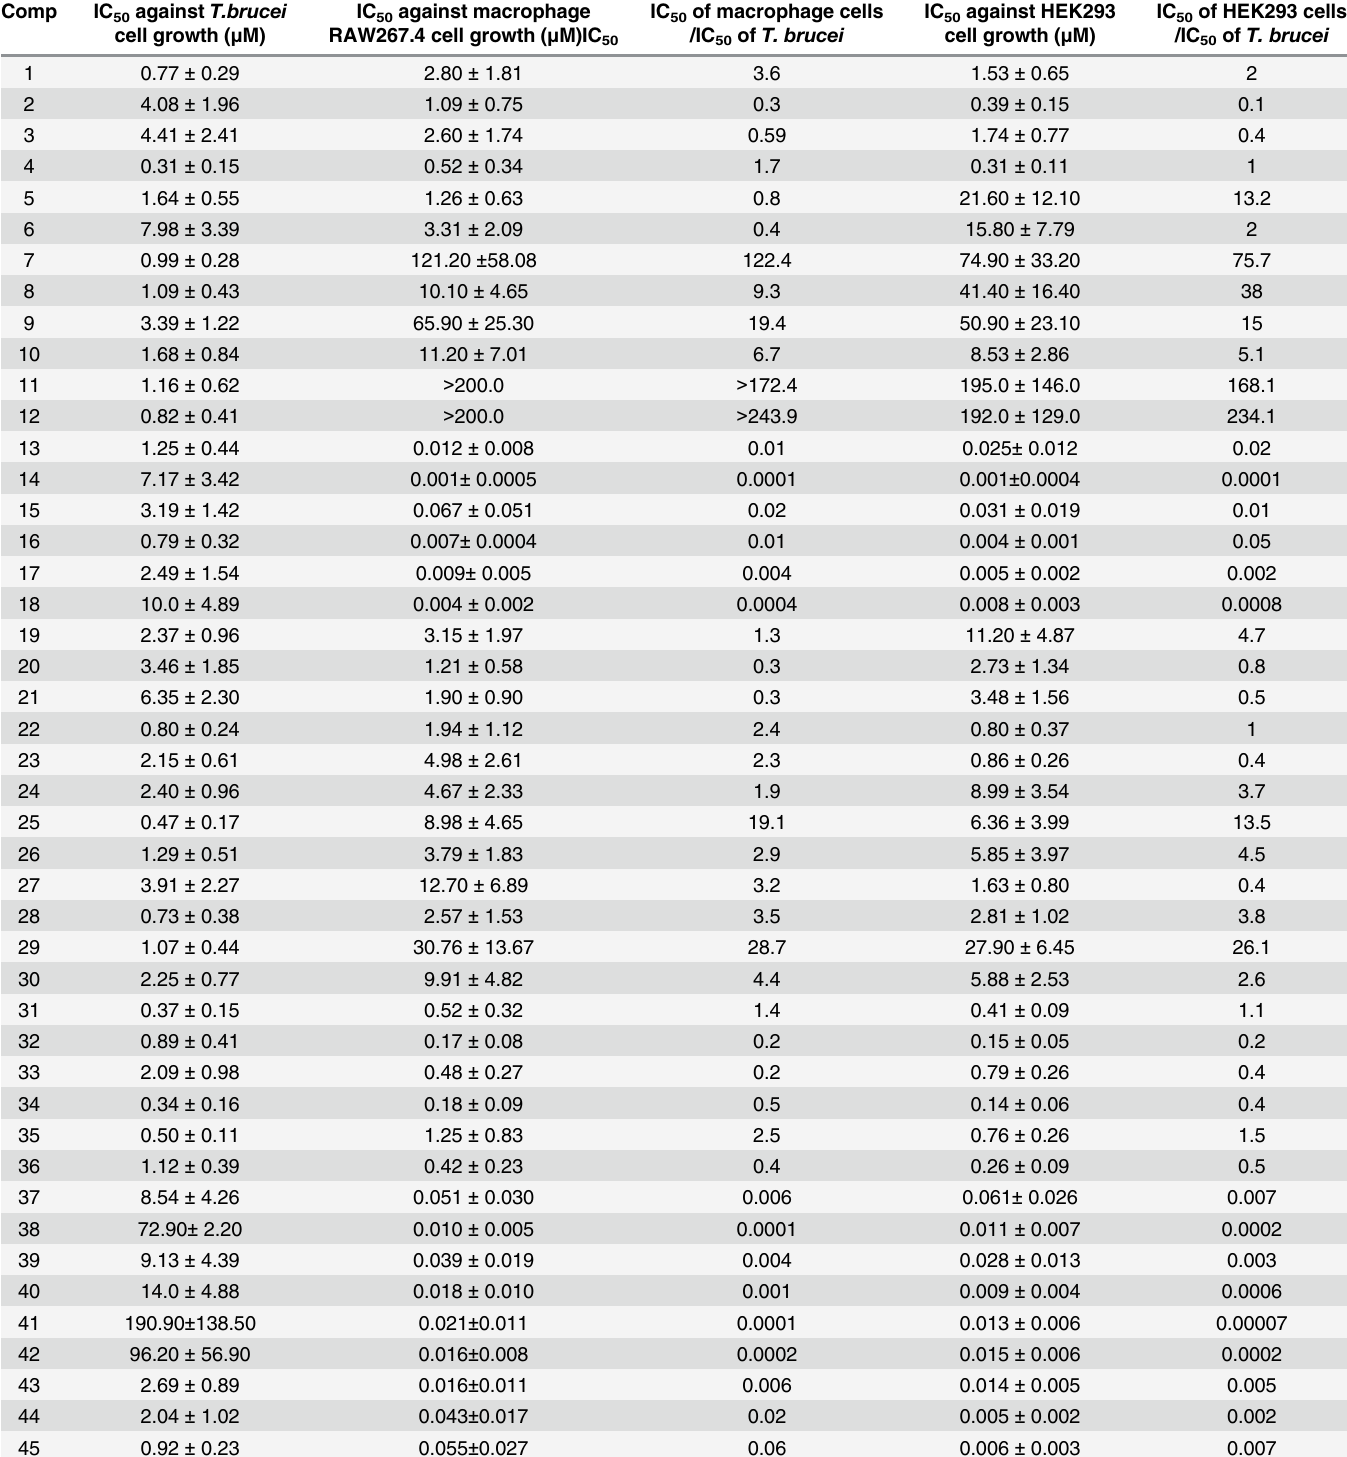
Table 1. Comparison of the growth inhibitory effects of the tubulin inhibitors on mammalian and T . brucei cells (IC 50 ± standard deviations are used to indicate the potency of the compounds).